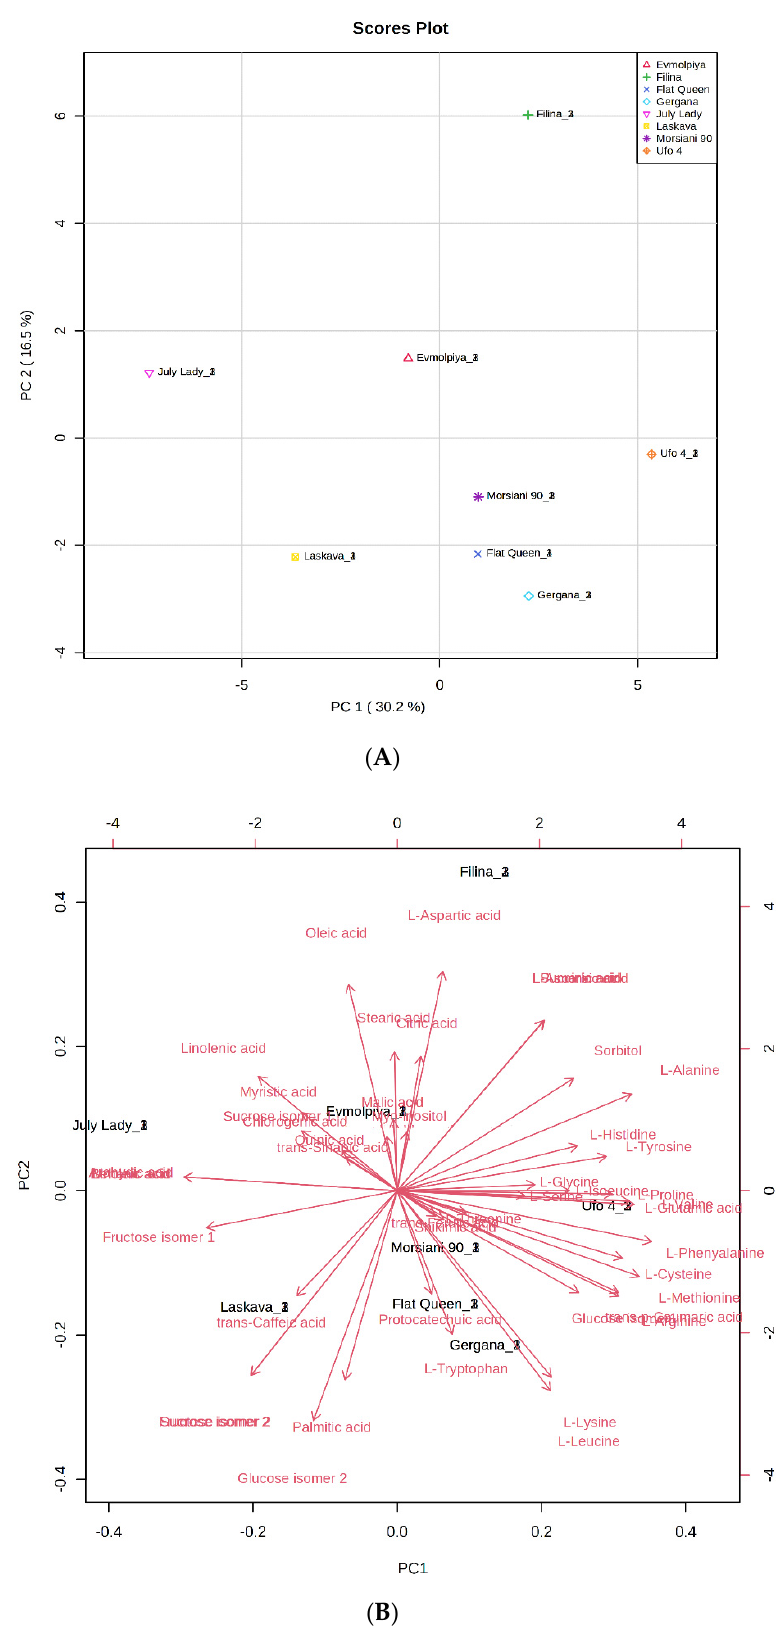
Figure 2. Principal component analysis (PCA) of GC-MS data of peach ( Prunus persica L.) varieties’ metabolites. ( A ) Principal component score plot for the eight peach varieties. ( B ) Eigenvector load values of compounds identified in the eight peach varieties.